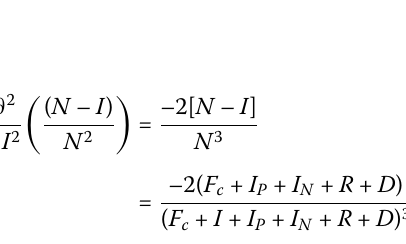
Figure 6 Numerical simulation of the reproductive number as functions of β and